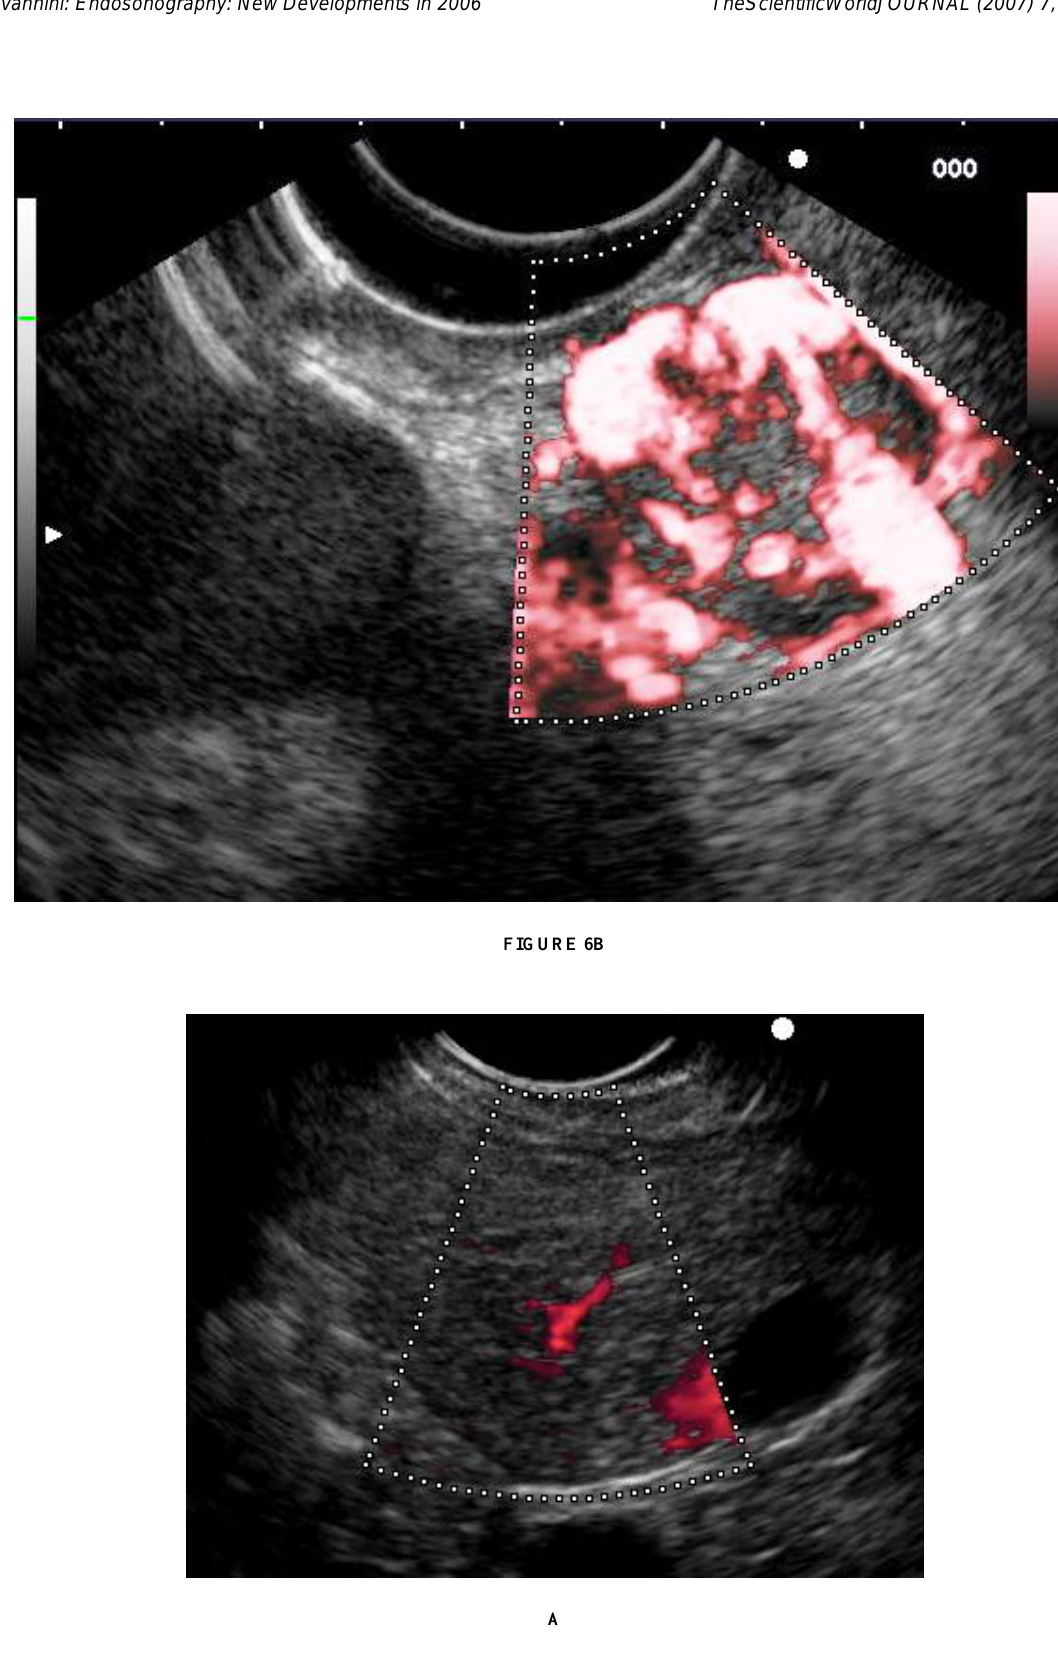
FIGURE 7 . (A) Nodule of chronic pancreatitis of the head of pancreas; (B) enhancement of vascularization after sonovue